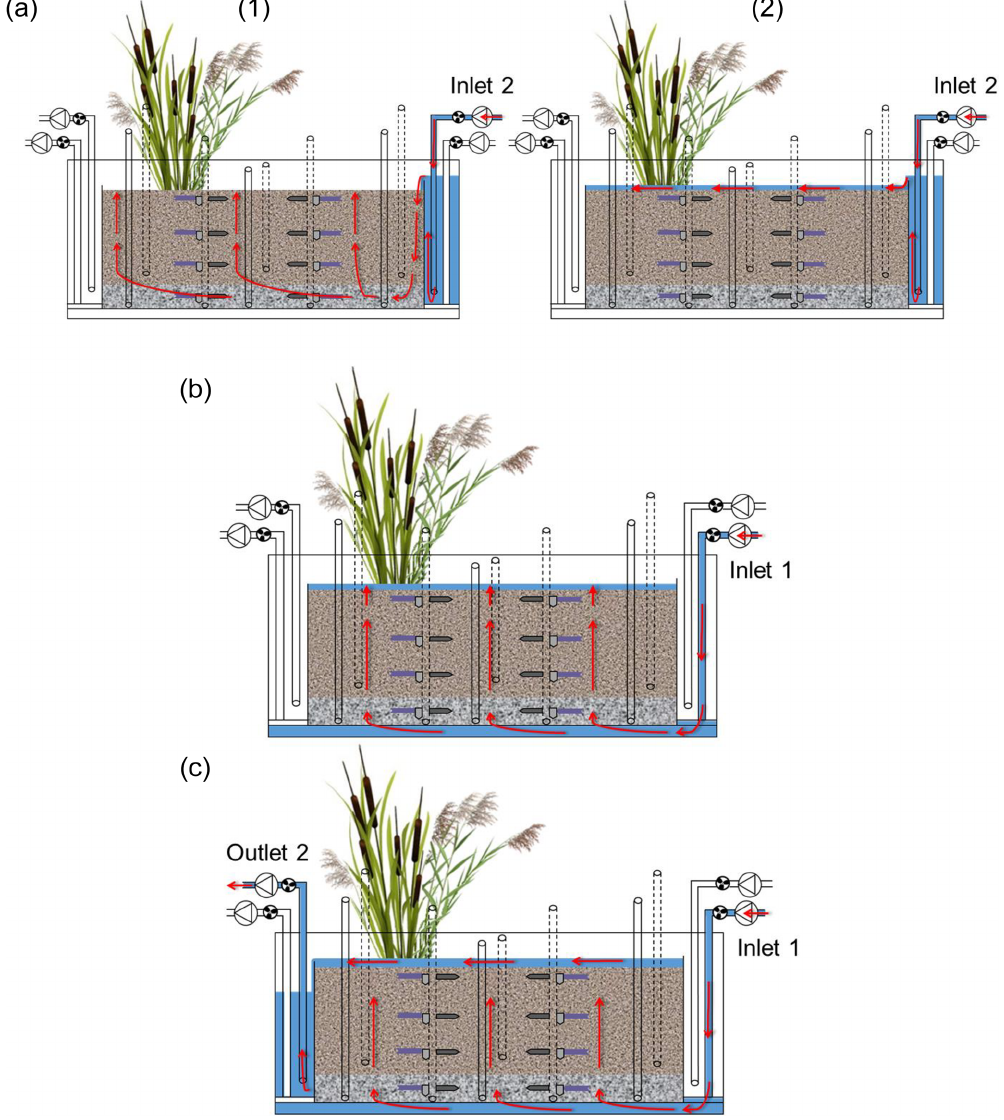
Figure 3. Front view of the model constructed wetland system showing the execution of the injections (red arrows indicate the direction of the water flow): (a) surface injection of tracers and pesticides, (1) corresponds to the upward vertical filling and (2) to the flow on the surface while the ponding was forming, (b) injection of tap water from the bottom and (c) flushing of the system with tap water from the